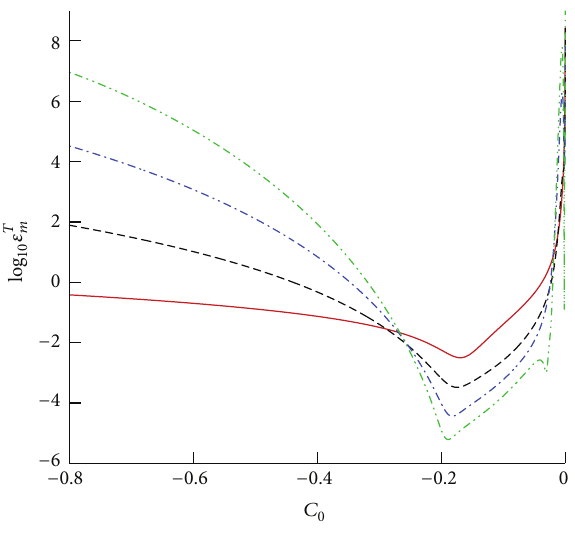
Figure 1: Residual squares of log 10 𝜀 𝑇 𝑚 versus 𝑐 0 . Solid line: first- order approximation; dashed line: third-order approximation; dash-dotted line: fifth-order approximation; dash-dot-dotted line: seventh-order approximation.